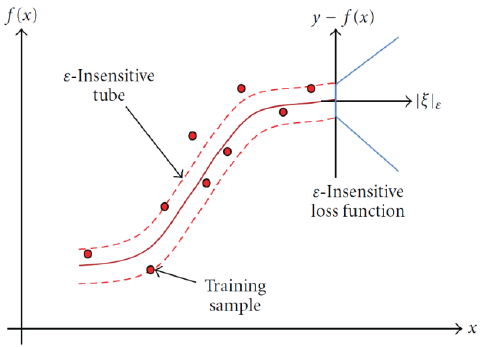
Figure 2. Example of a possible choice of the ε-insensitive loss function characterizing the Supported Vector Regression (SVR) learning approach (after [37]). Vector Regression (SVR) learning approach (after